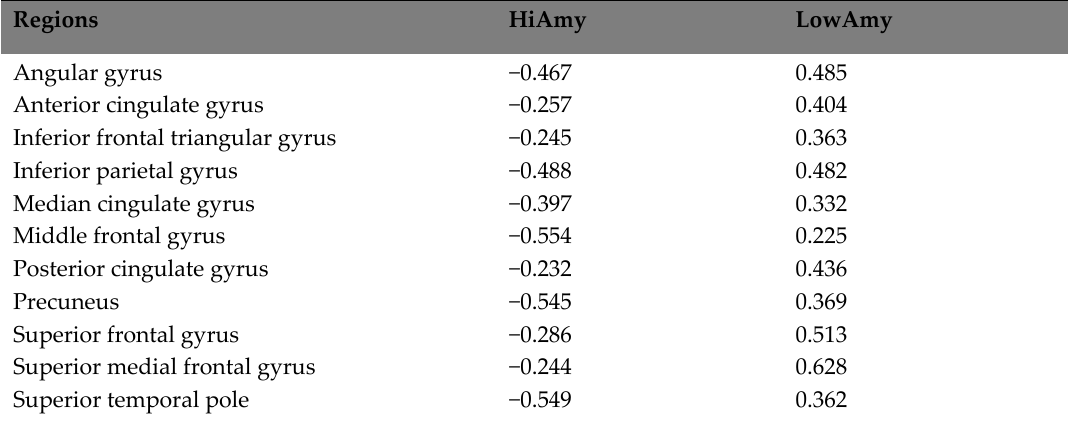
Figure 3. Correlation between A β burden and IFC in DMN.